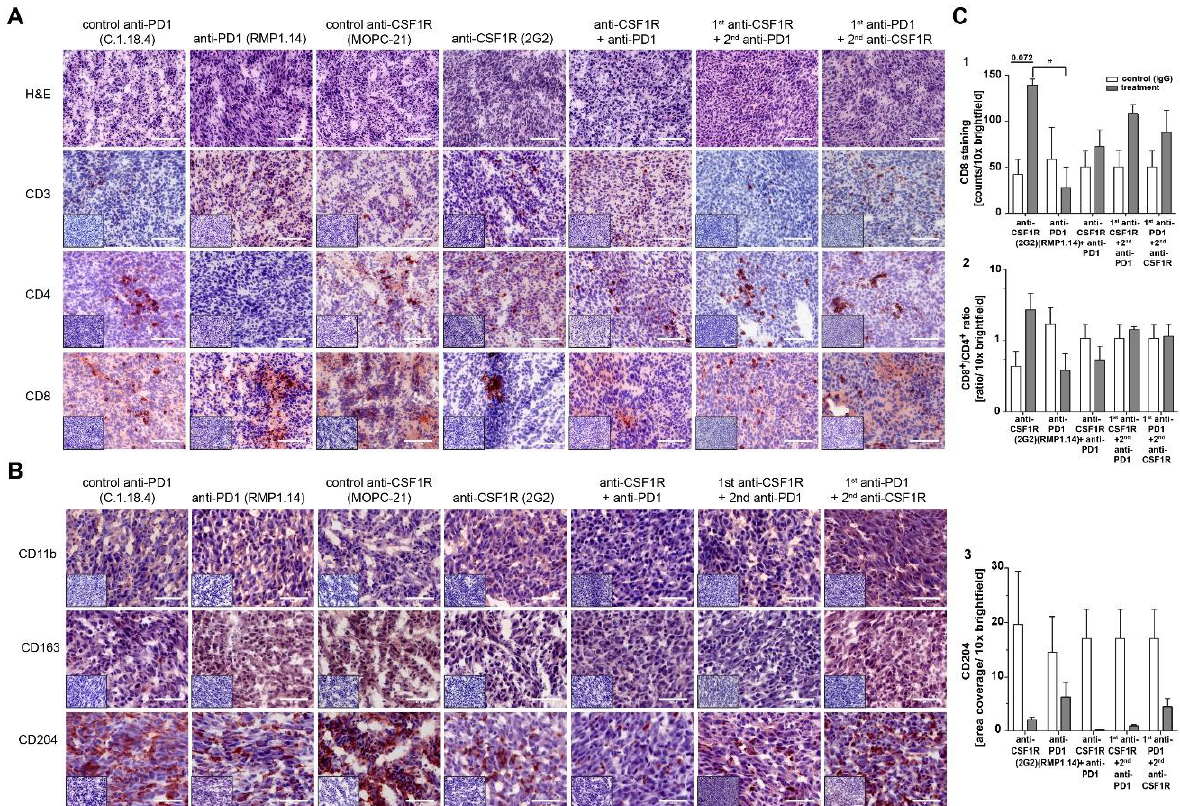
Figure 6. Immunohistochemical analysis of one representative animal per group ( n = 1) of tumor-infiltrating host cells in simultaneous versus sequential combinations of PD1 and CSF1R blockade in vivo. ( A ) , H&E and immunohistochemical analysis in representative tumor tissues. Scale bar 100 μm. ( B ) , Immunohistochemical analysis in representative tumor tissues. Scale bars 50 μm. Small inserts show staining control without application of primary antibody. ( C ), Quantification of CD8 + ( 1 ), CD8 + /CD4 + ratio ( 2 ), and CD204 + ( 3 ) cells. For quantification, three tissue samples of different tumor depth per animal were analysed. Statistical analysis was done using one-way ANOVA followed by Tukey’s multiple comparison test. p < 0.05.